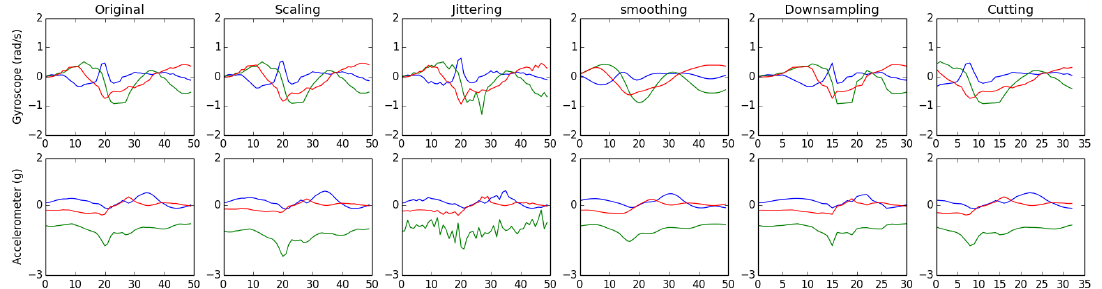
Figure 2. Synthetic data. Top images show gyroscope data while bottom show accelerometer data. From left to right: original signals, synthetic data modifying magnitude of signals (scaling, jittering, and smoothing), and synthetic data modifying frequency of signals (downsampling, and